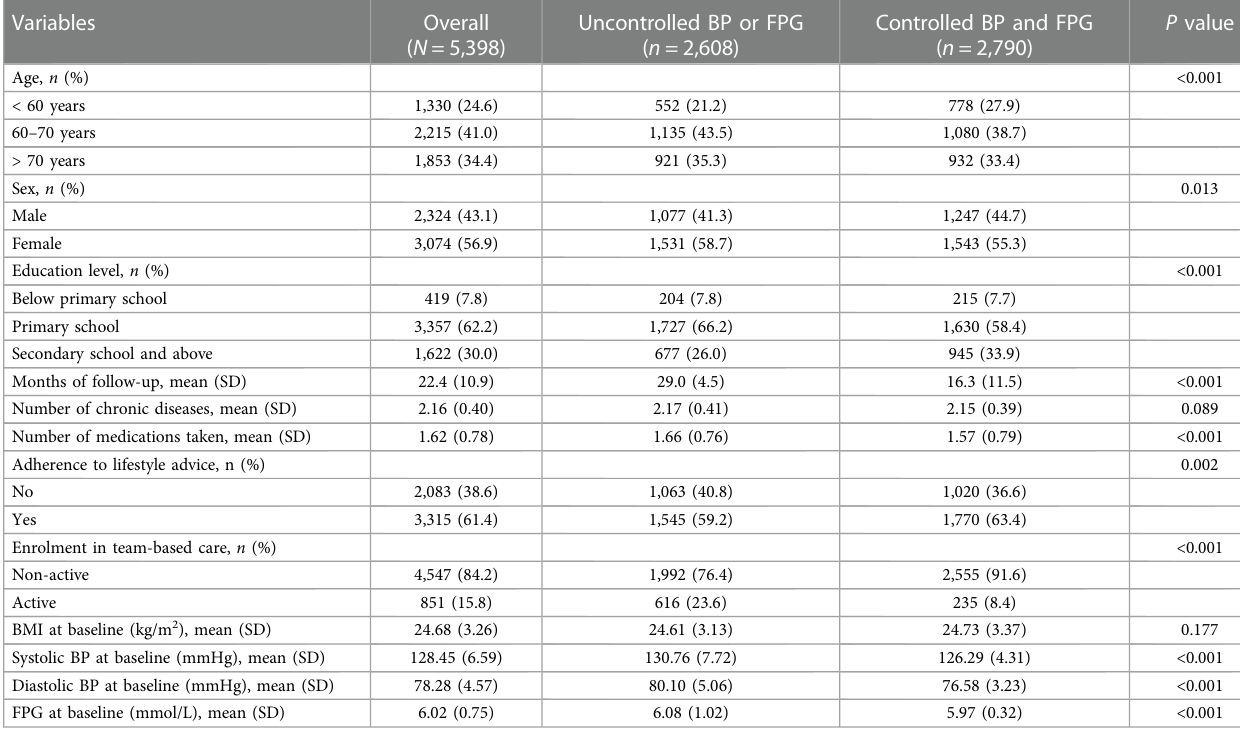
TABLE 1 Characteristics of study participants according to control of blood pressure and fasting plasma glucose at baseline.